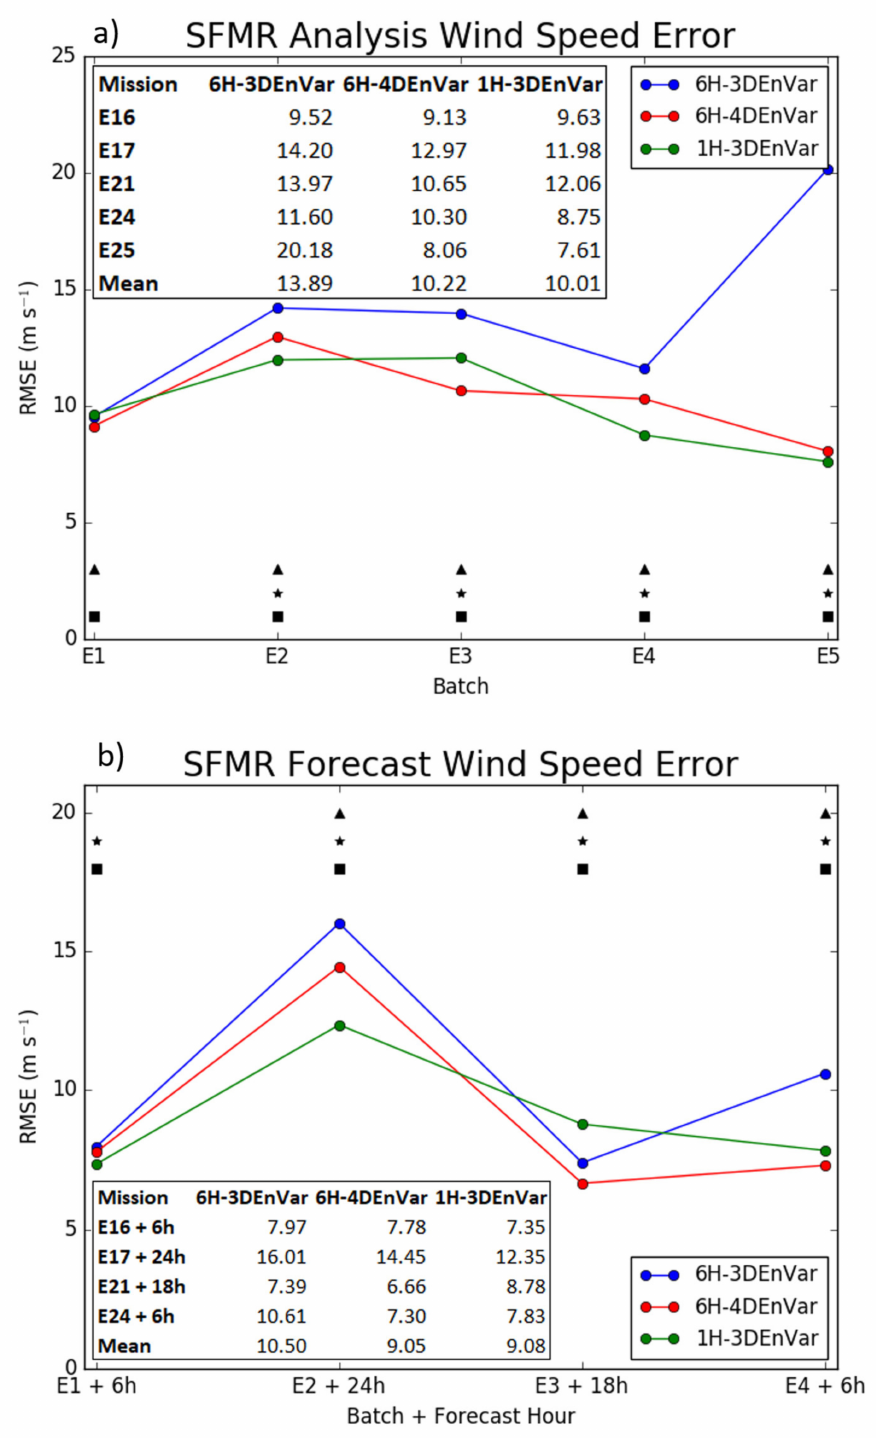
Figure 6. Wind speed ( a ) Analysis error and ( b ) Forecast as verified using Stepped Frequency Microwave Radiometer (SFMR). The value for each experiment is combined RMSE of the penetrating legs for each case. Black triangles indicate statistically significant difference between 6H-3DEnVar and 6H-4DEnVar at 95% level, black stars indicate statistically significant differences between 6H- 3DEnVar and 1H-3DEnVar at 95% level, and black squares indicate statistically significant differences between 6H-4DEnVar and 1H-3DEnVar at 95%